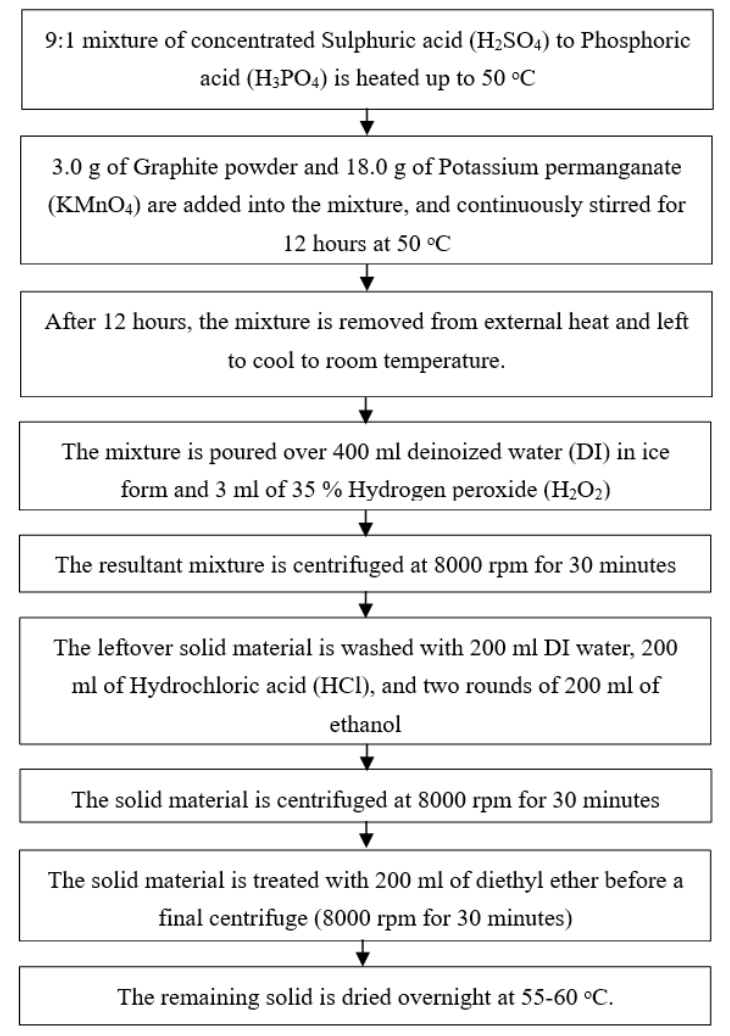
Figure 1. Graphene Oxide synthesizing process using Tour’s method.